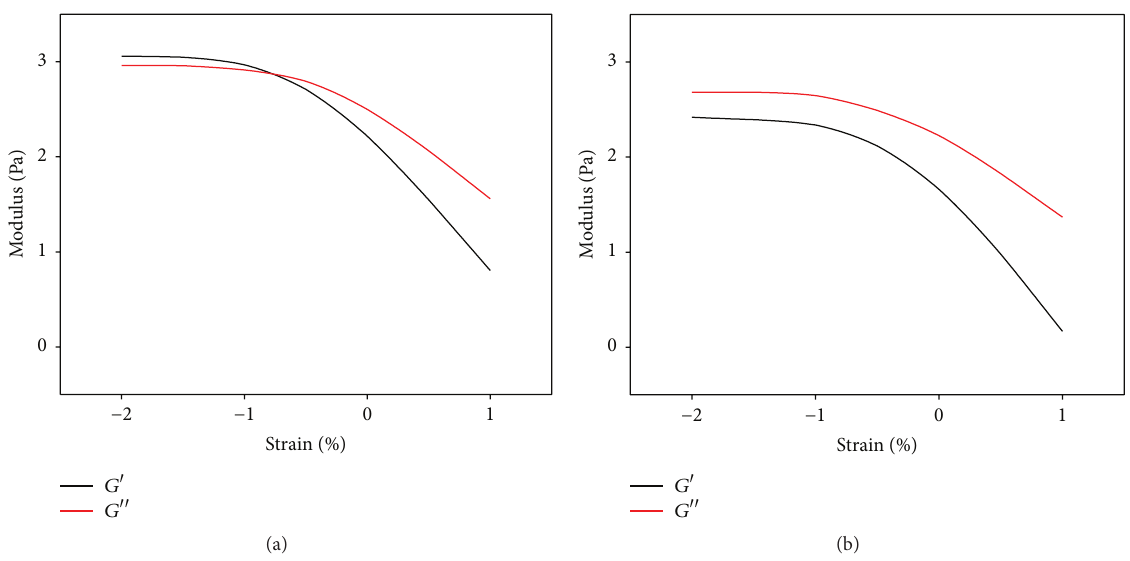
Figure 13: Strain sweep curves: (a) [MG49-25.0 wt.% LiClO 4 ]:[8.0 wt.% HNO 3 -THF/TiO 2 -SiO 2 ] and (b) [MG49-25.0 wt.% LiClO 4 ]:[8.0 wt.% ClHNO 2 -THF/TiO 2 -SiO 2 ] polymer electrolytes.